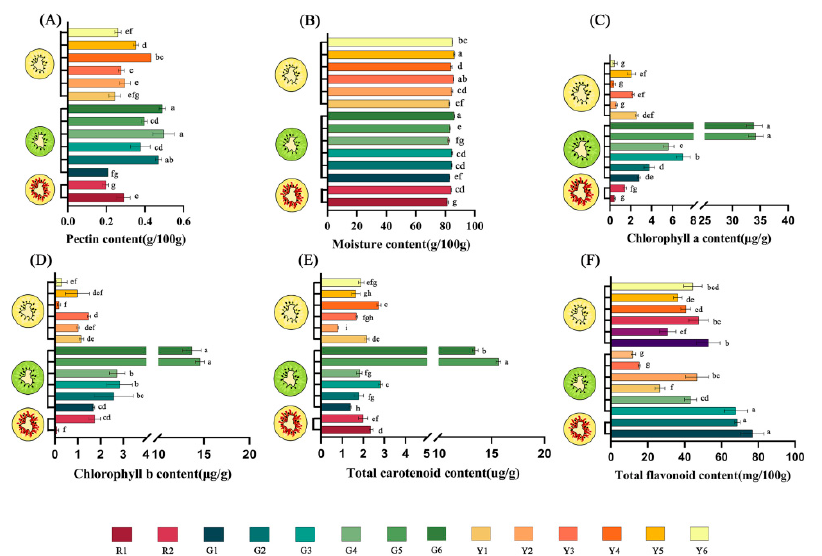
Figure 1. The contents of pectin, moisture, chlorophyll a, chlorophyll b, total carotenoids and total flavonoids. ( A ) The contents of pectin. ( B ) The contents of moisture. ( C ) The contents of chlorophyll a. ( D ) The contents of chlorophyll b. ( E ) The contents of total carotenoids. ( F ) The contents of total flavonoids. ‘R1’, ‘Hongyang’. ‘R2’, ‘Donghong’. ‘G1’, ‘Cuiyu’. ‘G2’, ‘Xuxiang’. ‘G3’, ‘Hayward’. ‘G4’,